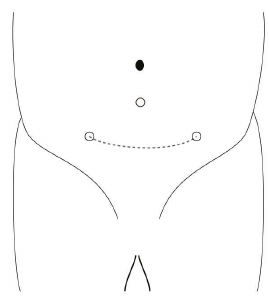
Figure 4: With traction on the ureteric stent using a blunt grasper, the fibrovascular tissue surrounding the lower ureter can be seen and divided using fine 3-mm endoscopic scissors and diathermy hook, while preserving the main ureteric blood supply.